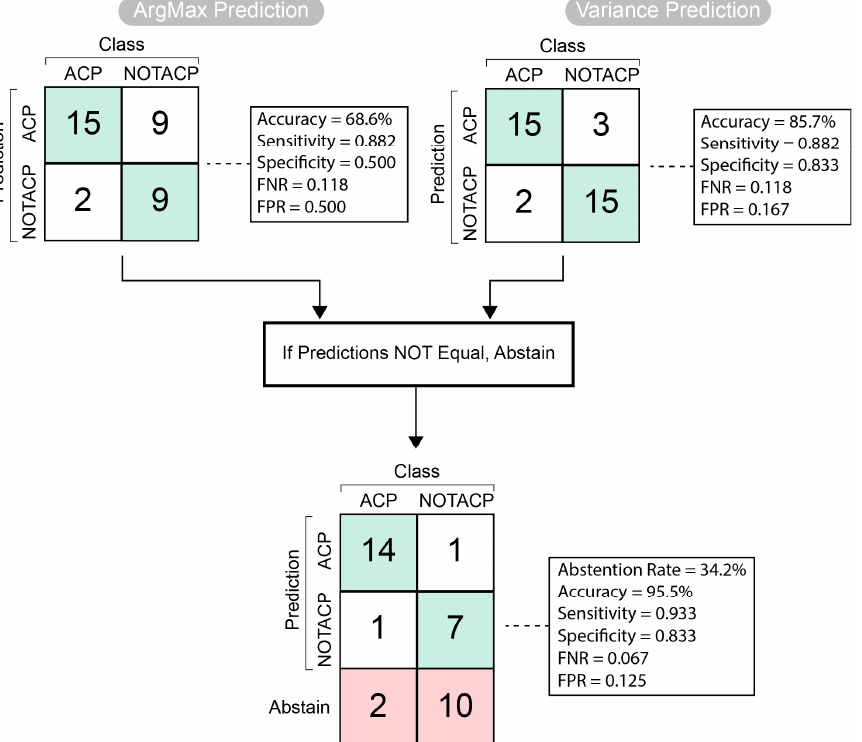
Figure 5. Abstention algorithm components and performance. Prediction by argument maximum is presented in the top-left and prediction by variance, each with associated performance metrics. The final prediction with abstentions is presented at the bottom.